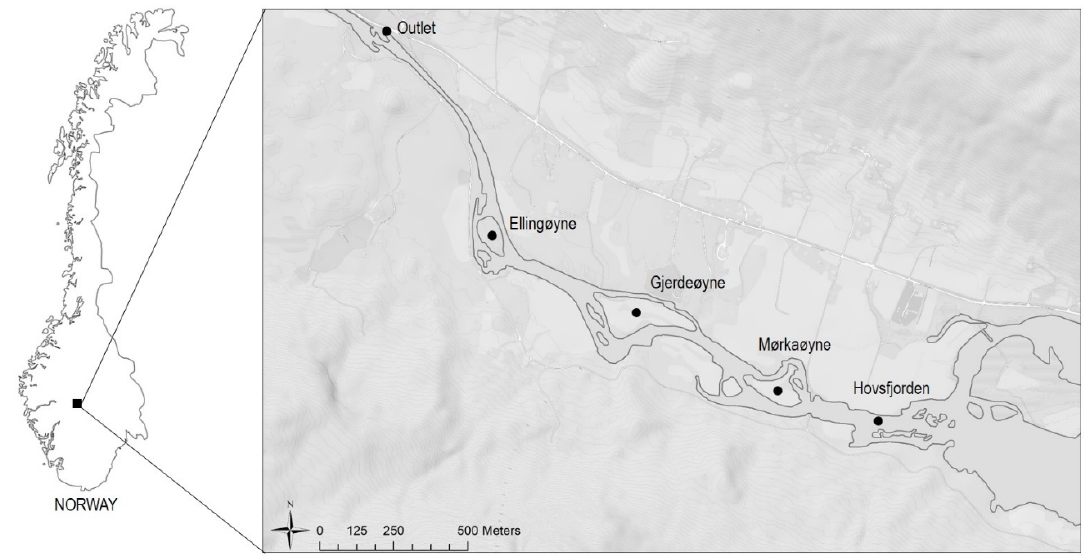
Figure 1. Illustration of Storåne river location in Norway and location of the selected study area from the outlet Hol 1 hydropower plant to Hovsfjorden with the braided channels forming around the three main islands.